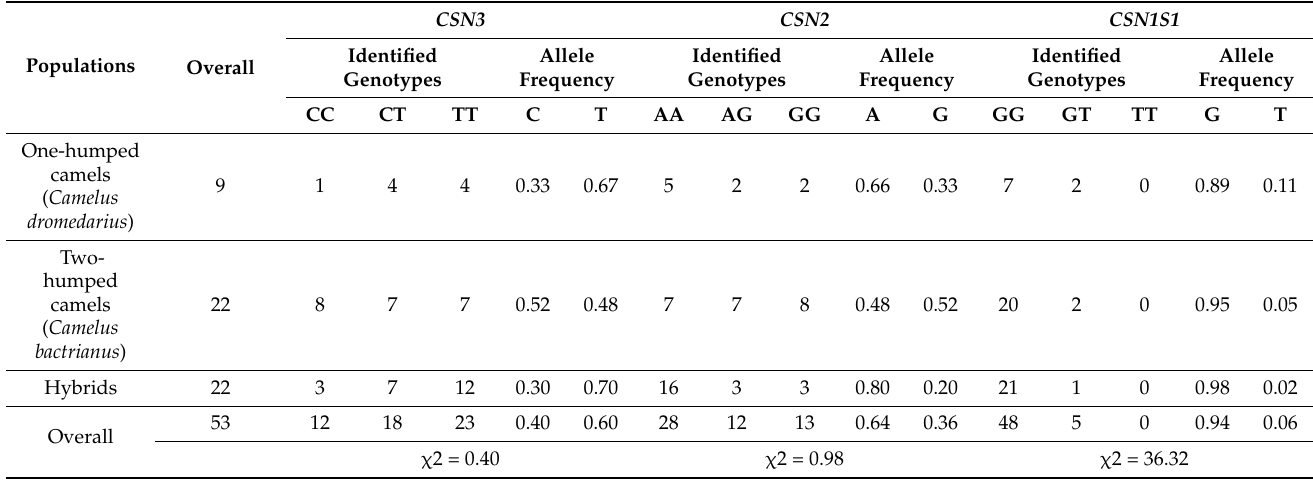
Table 3. CSN3, CSN2, and CSN1S1 genotype distribution in one-humped, two-humped camels and their hybrids.